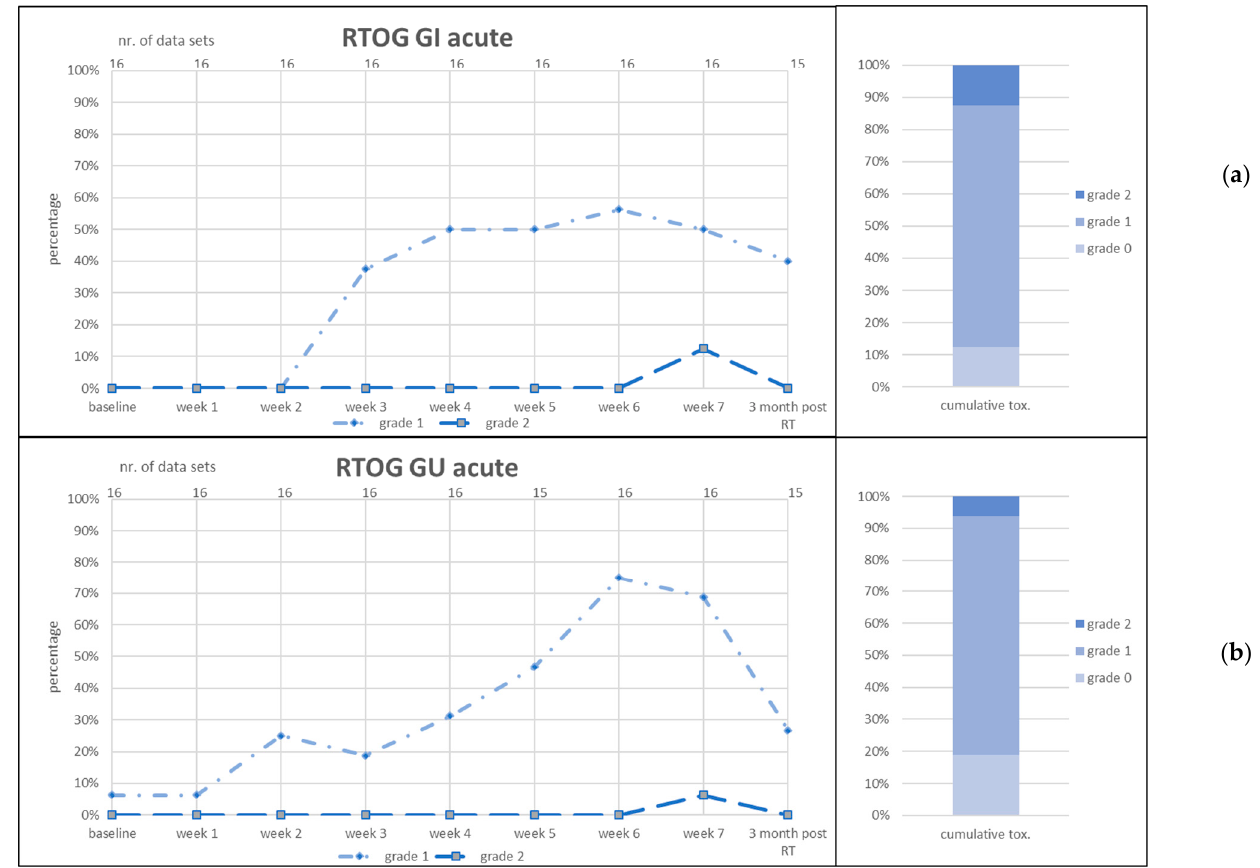
Figure 5. Acute gastrointestinal (GI) toxicity scored as RTOG GI acute ( a ) and genitourinary (GU) toxicity scored as RTOG GU acute ( b ). RT = radiotherapy. Left graphs: number of patients in percent ( y -axis) who reported the toxicity item at the given point of time (lower x -axis). Number of data sets in upper x -axis. Right graphs: cumulative toxicity of the given item up to 3 months post RT.